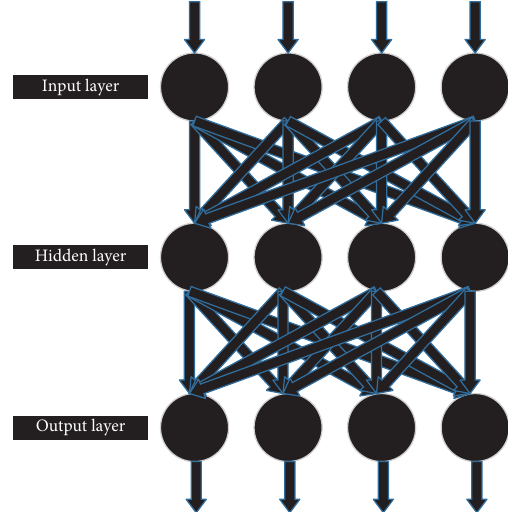
Figure 1: The basic structure of